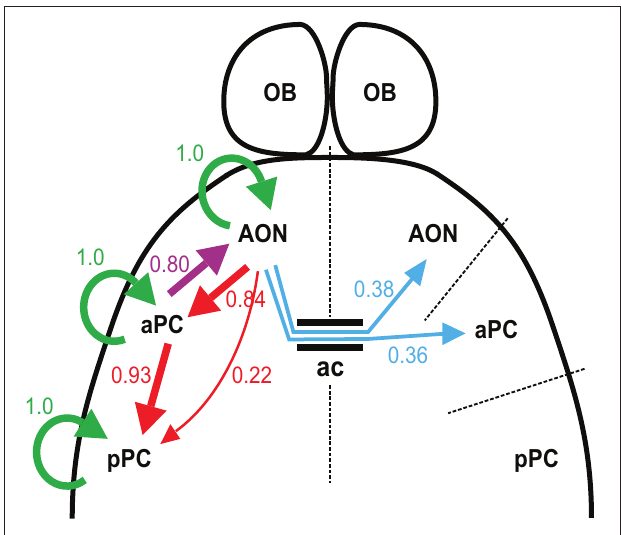
FIGURE 9 | Summary of connections. Wiring diagram based on the probability of finding functional connections in our experiments. The width of the arrow is correlated with the probability, with the numbers appearing next to the arrows. Connections from aPC to AON, and those within the AON are from data not shown in the paper. Ac, anterior